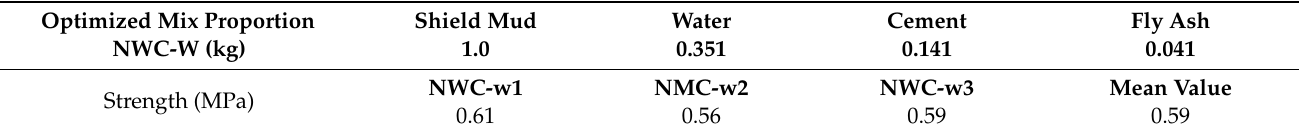
Table 7. Optimized mix proportion and 7 d compressive strength test